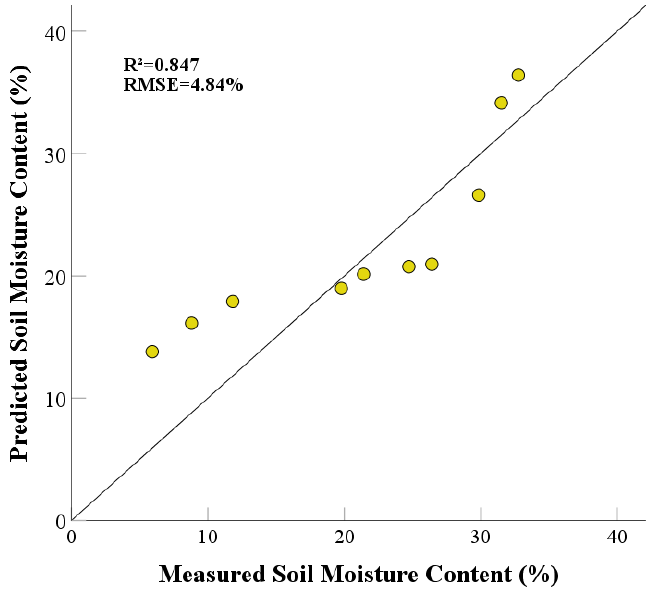
Figure 5. The scatting plot between the measured and predicted soil moisture content.